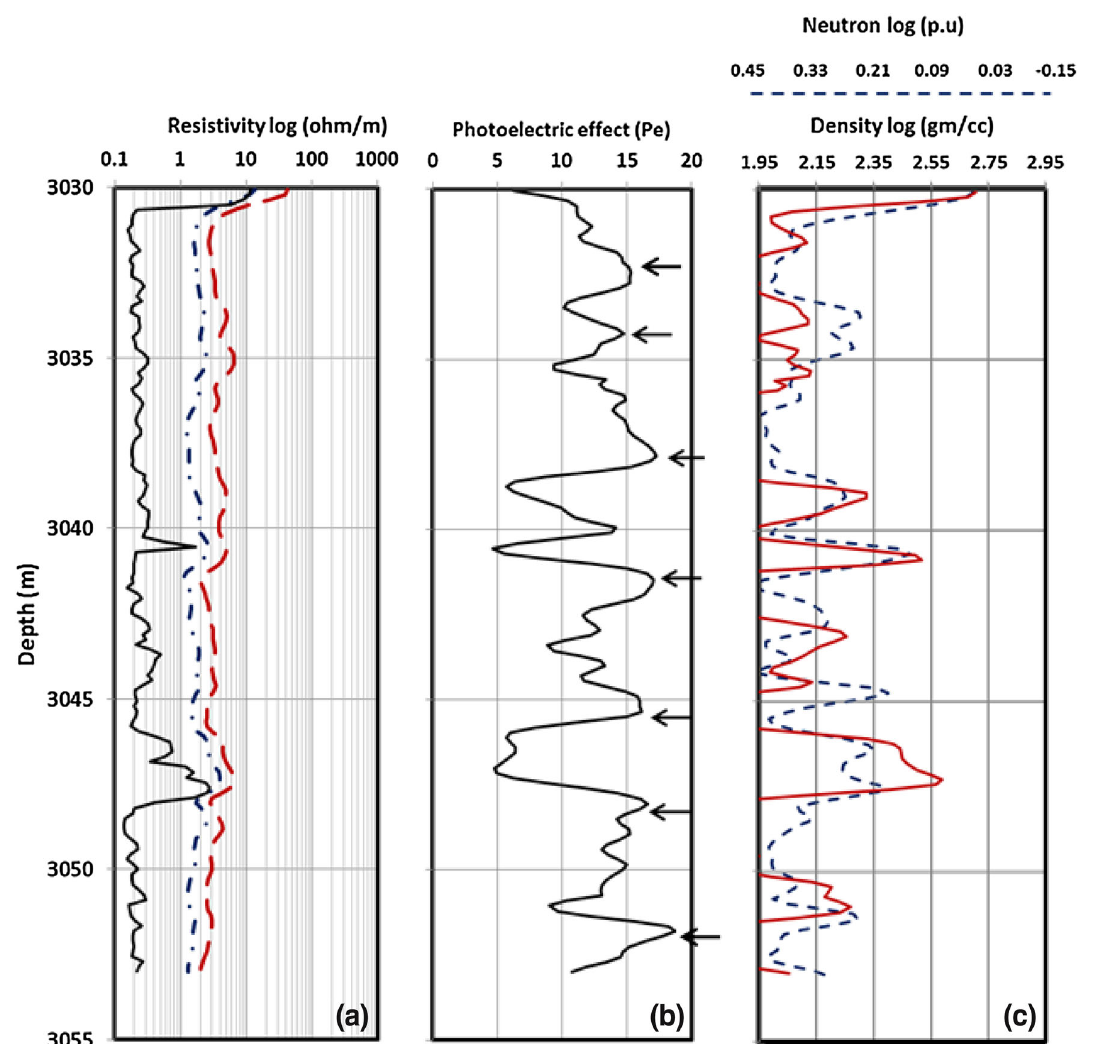
Fig. 7 Fractures indicated from well logging in Tawila N-1 Well, a Dual Laterolog–MSFL, separation indicating high permeable zone, b photoelectric effect (Pe) increases showing fracture zones,